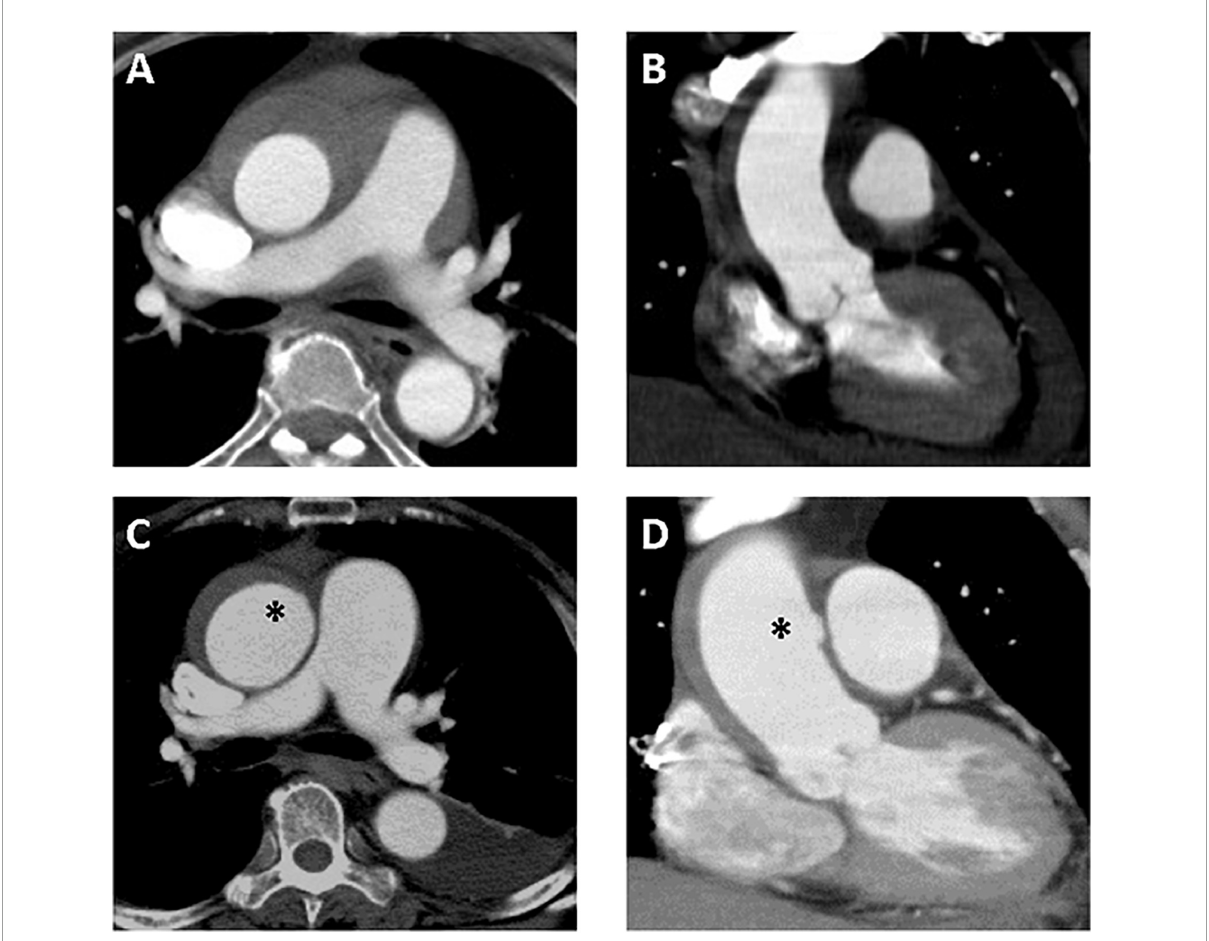
FIGURE4 A 61-year-old woman with TAIMH and newly developed ULP. Type A intramural hematoma (thickness 12 mm) was identified on initial contrast-enhanced CT scan and no focal intimal disruption was visible in the axial (A) and coronal view (B) . Follow-up CT scan obtained on sixth day of admission showed an irregular margin of aortic wall (asterisk) in the axial view (C) that a newly developed ULP (asterisk) was confirmed in the coronal view (D) . The patient suffered from sudden death on the 12th day of admission. CT, computerized tomography; TAIMH, type A aortic intramural hematoma; ULP, ulcer-like